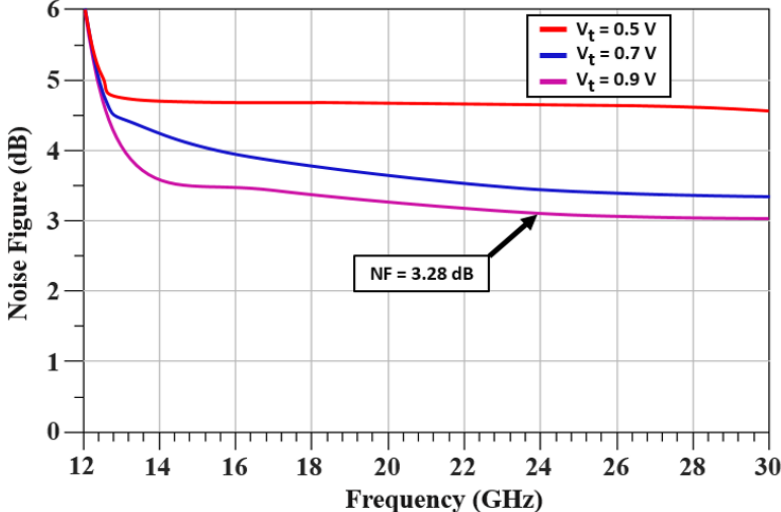
Figure 16. Noise figure for various tuning